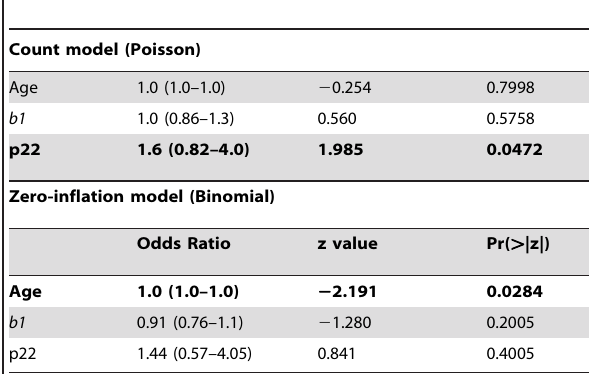
Table 4. Prediction of difference in swelling size between initial and final measurements at the bovine tuberculin injection site ( db ) by ‘22’